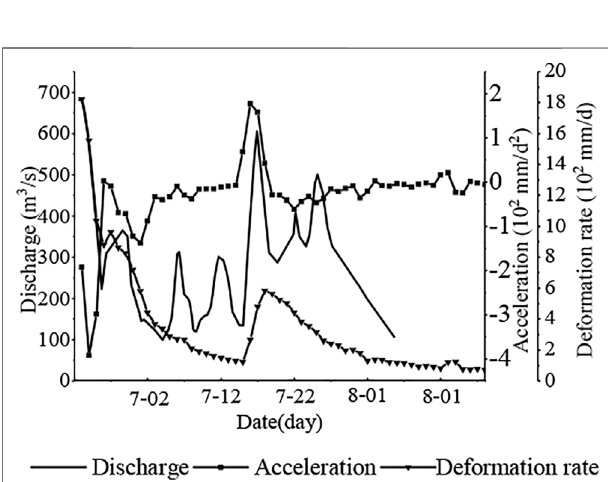
FIGURE 6 | Deformation rate and acceleration of monitoring point JC22 and river discharge. The river fl ow data are from the Guanzhou power station, whose location is shown in Figure 1D . The river fl ow data in Figure 6 are the same as those in Figure 7 .